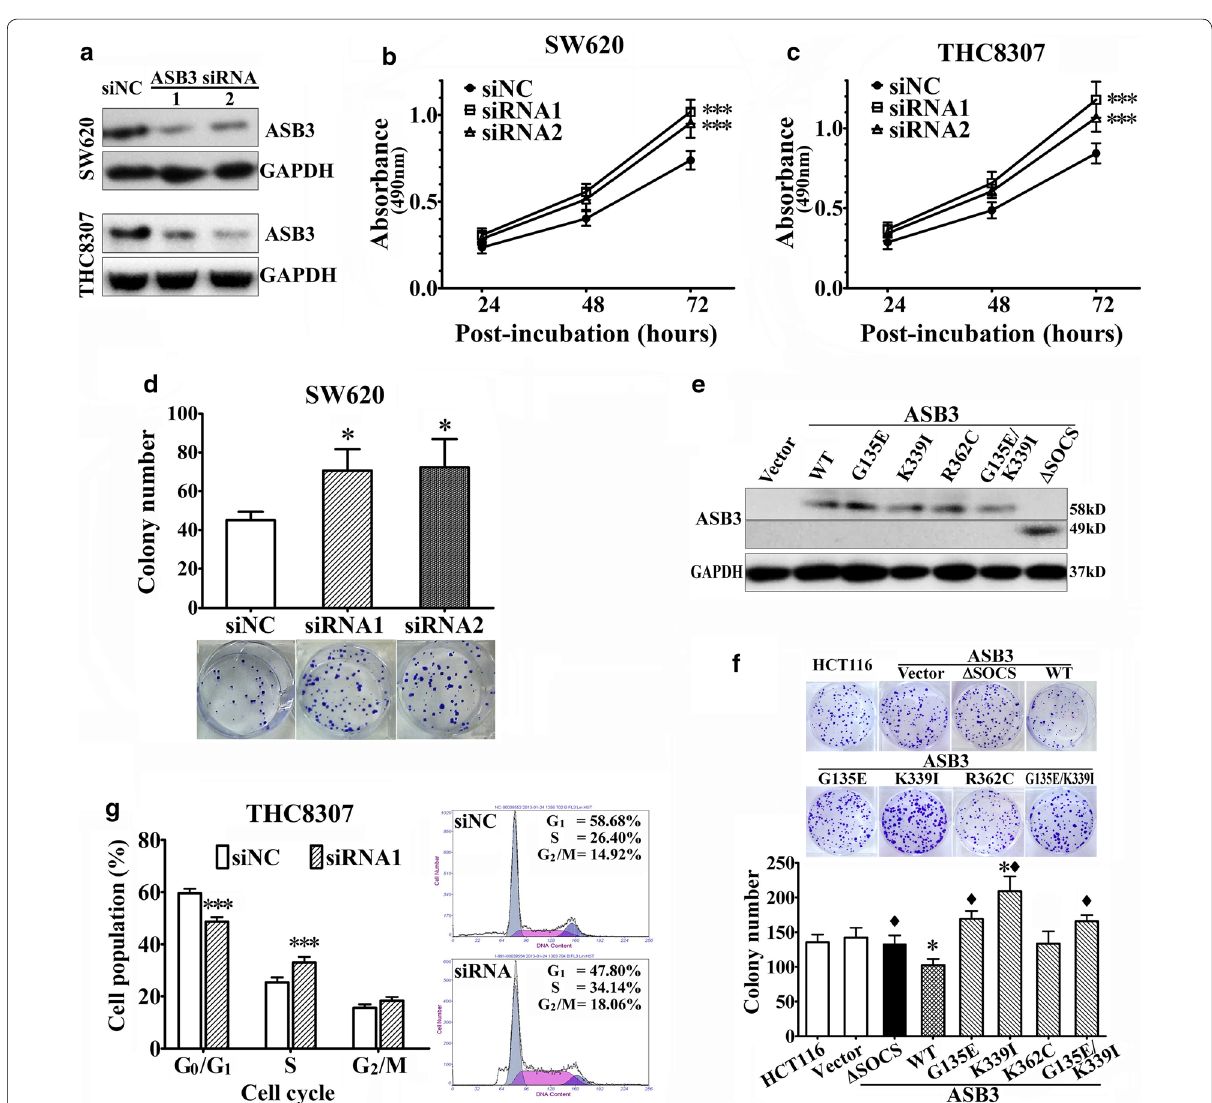
Fig. 2 ASB3 inhibits the proliferation of CRC cells in vitro. ASB3 protein levels, cell proliferation, or cell cycle distributions were analyzed in CRC cells using Western blotting assay ( a and e ), MTT assay ( b and c ), colony formation assay ( d and f ), or flow cytometry ( g ) after ASB3 knockdown by transiently transfected with small interfering RNAs (siRNAs) or after ASB3 overexpression by stably transfected with ASB3 cDNA or its mutants. siNC, negative control siRNA; WT, wild type; G135E, K339I, R362C, and ΔSOCS are ASB3 mutants. Representative pictures are also included in d , f , and g . * P < 0.05 compared with those transfected with siNC or vector control; ♦ P < 0.05 compared with that transfected with WT ASB3; *** P < 0.001 compared with that transfected with